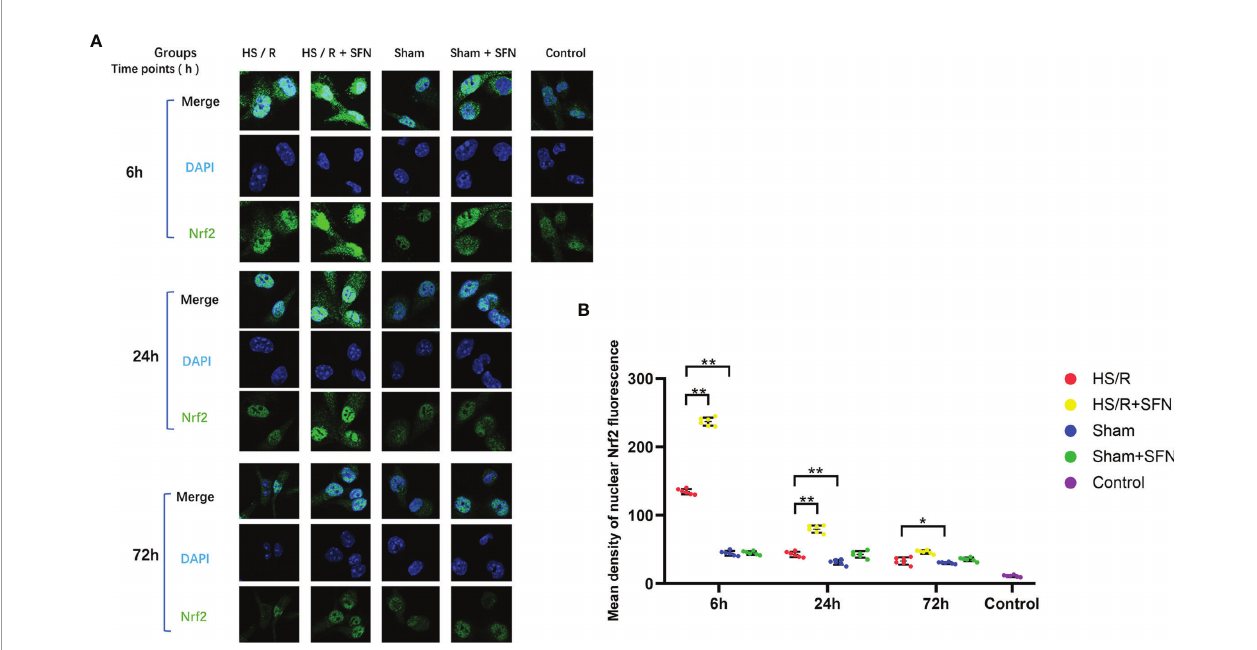
FIGURE 2 | Immuno fl uorescence analysis of Nrf2 nuclear translocation (n=6 in each group). (A) Kupffer cells were isolated from the WT mice that underwent the different experimental procedures and were fi xed immediately. Nrf2 was probed with a primary anti-Nrf2 antibody and visualized with a goat anti-Rabbit DyLightH 488- conjugated secondary antibody. The nuclei were stained with DAPI. The images were taken using confocal fl uorescence microscopy. (B) The quantitative analyses of the mean intensity of fl uorescence ( l = 488nm) in the nuclei were performed with the AxioVision Rel. 4.8 software (Carl Zeiss Micro Imaging, LLC) (*p < 0.05, **p < 0.01; One-way ANOVA followed by Tukey ’ s post hoc